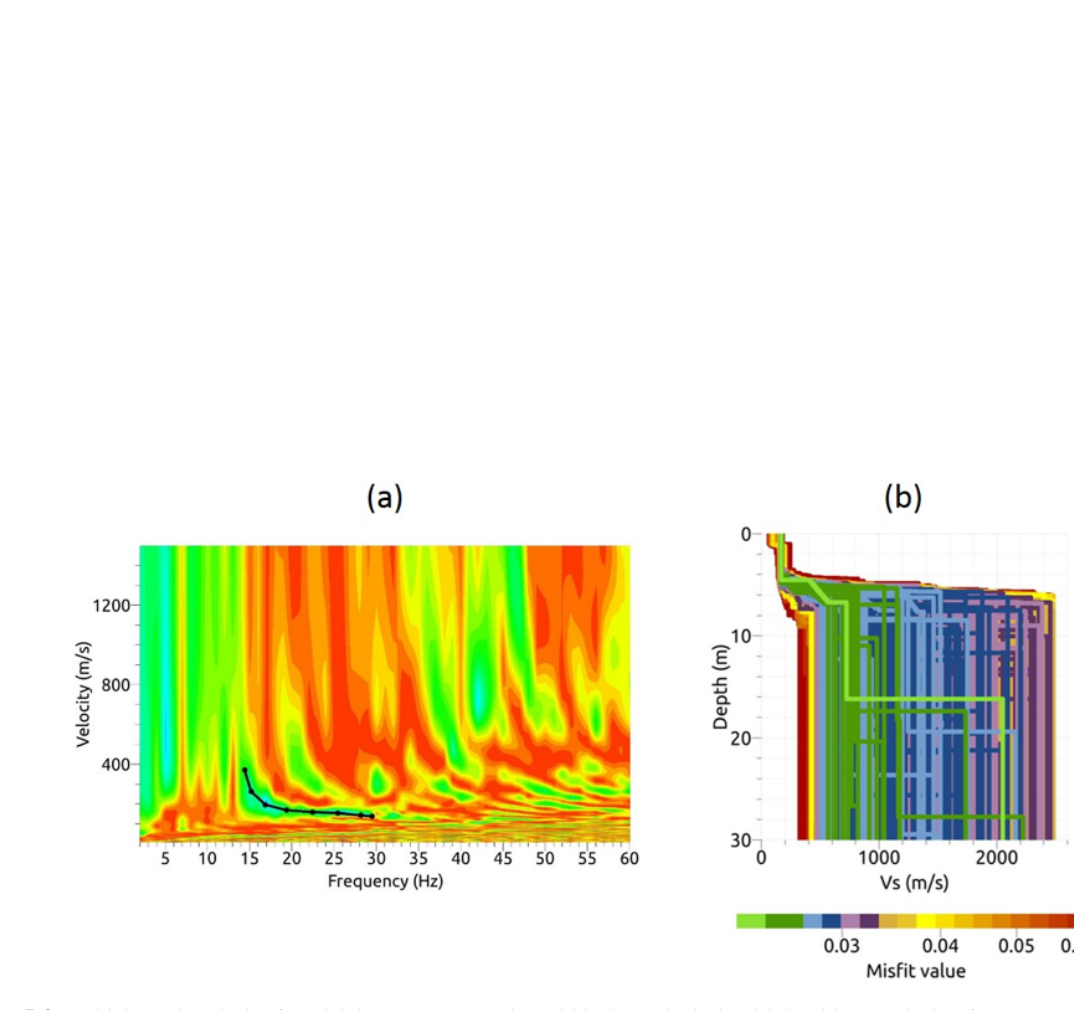
Figure D3. Multichannel analysis of Rayleigh waves propagating within the rock glacier. (a) Semblance velocity–frequency map highlighting several modes, the fundamental dispersion curve being picked as indicated by the black line, and (b) V s distribution versus depth derived from the inversion of the fundamental dispersion curve. Colors indicate the RMSE (color bar in %) between synthetic and picked fundamental dispersion curves (best-fitting model in